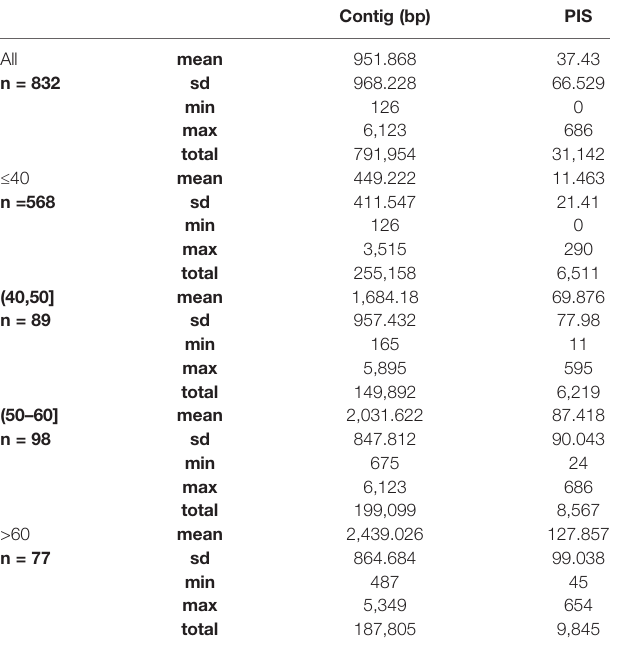
TABLE 1 | Summary statistics of the length in base pairs and the number of parsimony informative sites (PIS) for the alignments of all the 832 loci and the subsets de fi ned by the upper quartile of the RAxML rapid bootstrap support values of each gene tree ( ≤ 40, >40, >50, and >60%). Contig